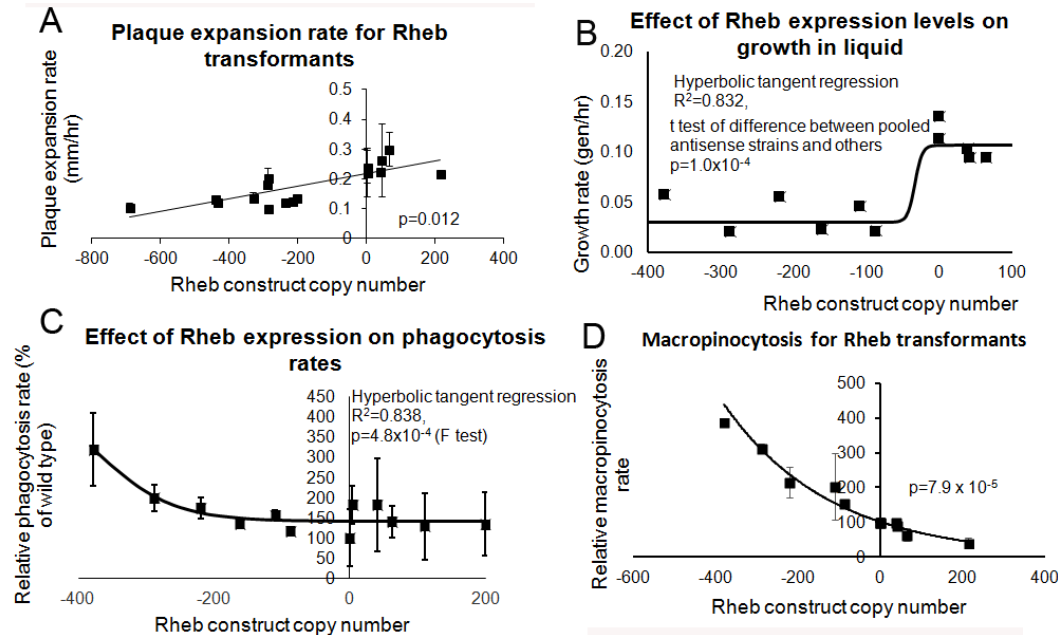
Figure 9. Rheb promotes growth and inhibits endocytosis. Wild type, Rheb antisense and Rheb overexpression transformants were measured for their growth ability and their endocytosis rates. Negative copy numbers represent the number of Rheb antisense constructs and positive copy number values represent the number of Rheb overexpression constructs ( A ) Cells were grown on E. coli B2 lawns and the diameter of each Dictyostelium plaque was measured twice daily for five days and the rate of plaque expansion calculated. ( B ) Cells were suspended to a final concentration of 1 × 10 4 cells·mL −1 and grown on a shaker at 21 °C. A small amount of medium containing Dictyostelium cells was removed and counted twice daily. The growth rate for each strain (generations / h) was then calculated. The growth rates in (A,B) correlated with the number of Rheb construct copy number showing that Rheb positively regulates growth. ( C ) The ability of cells to ingest a fluorescently labelled bacterium (DsRed-expressing E. coli ) was measured and results were normalised to wild type. The data show that reduced levels of Rheb expression result in increased rates of bacterial uptake. ( D ) The rate of uptake of medium containing the fluorescent marker FITC-dextran was measured and values were normalised against the wild type. The endocytosis rates in (C,D) show that Rheb negatively regulates endocytosis. Each point represents the mean from at least three independent experiments. The regressions were significant at the indicated p values ( t test in (A,D); and F test in (B,C). Lines were fitted by the least squares method to: a straight line (A); a modified hyperbolic tangent (B,C); and an exponential function (D).